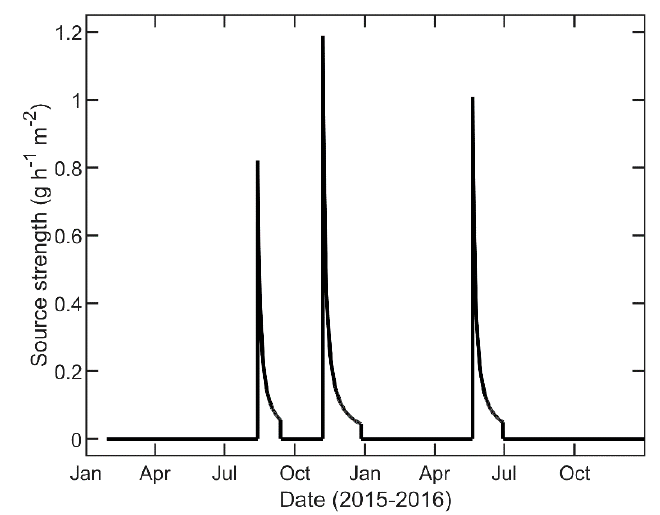
Figure 11. Source strength to account for water injections into wall cavities.